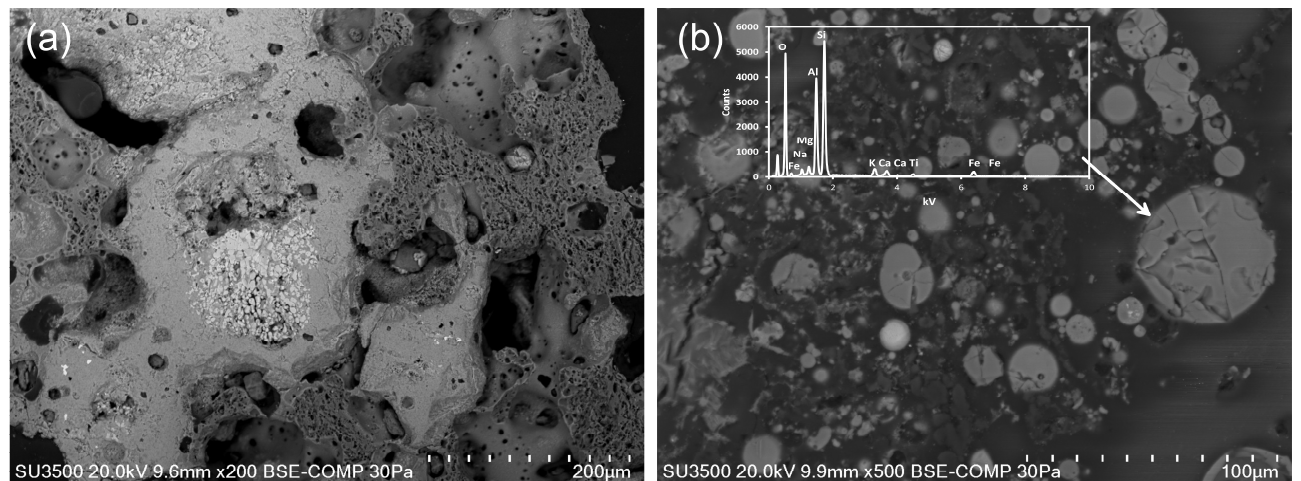
Figure 3. SEM image of glass grain: ( a ) sample LZ—numerous pores in the glass grain; ( b ) sample LMOS—EDS spectrum of glass grain.